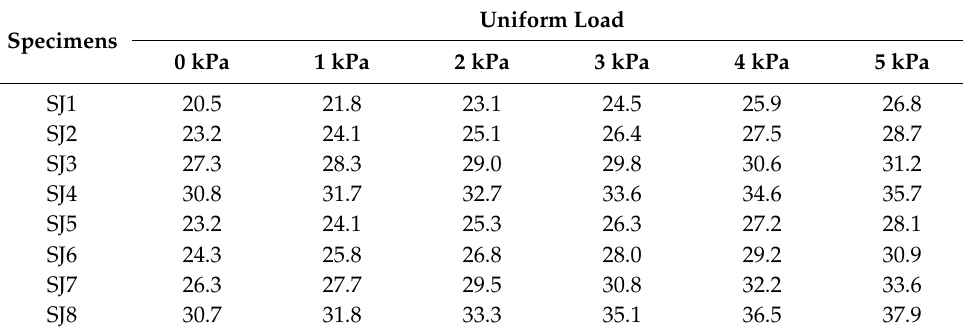
Table 4. The coupling stress of testing point S30 (MPa).